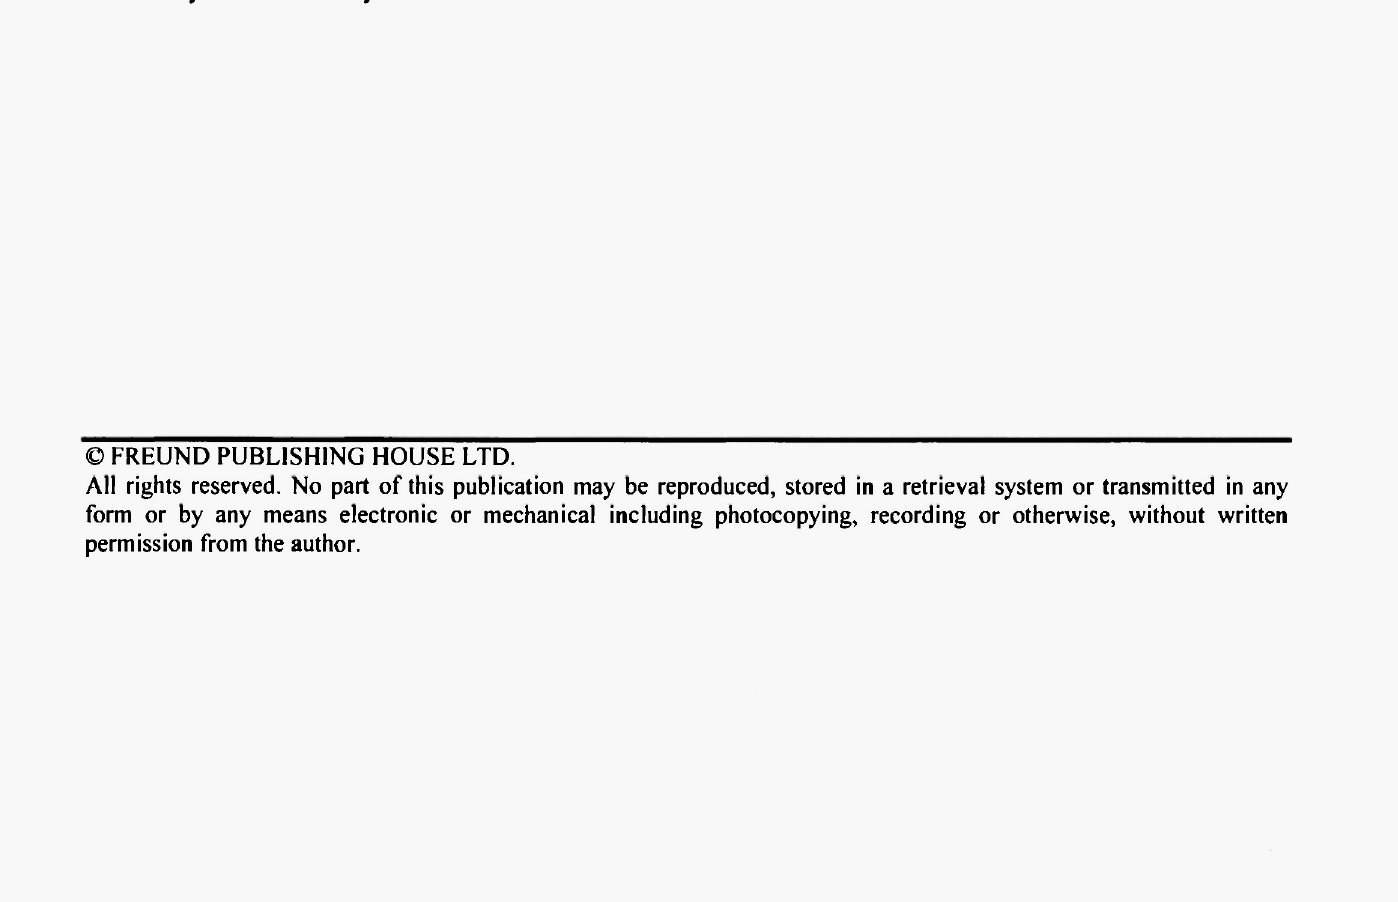
Derivation and Consistency of the Partial Functions of a Quaternary